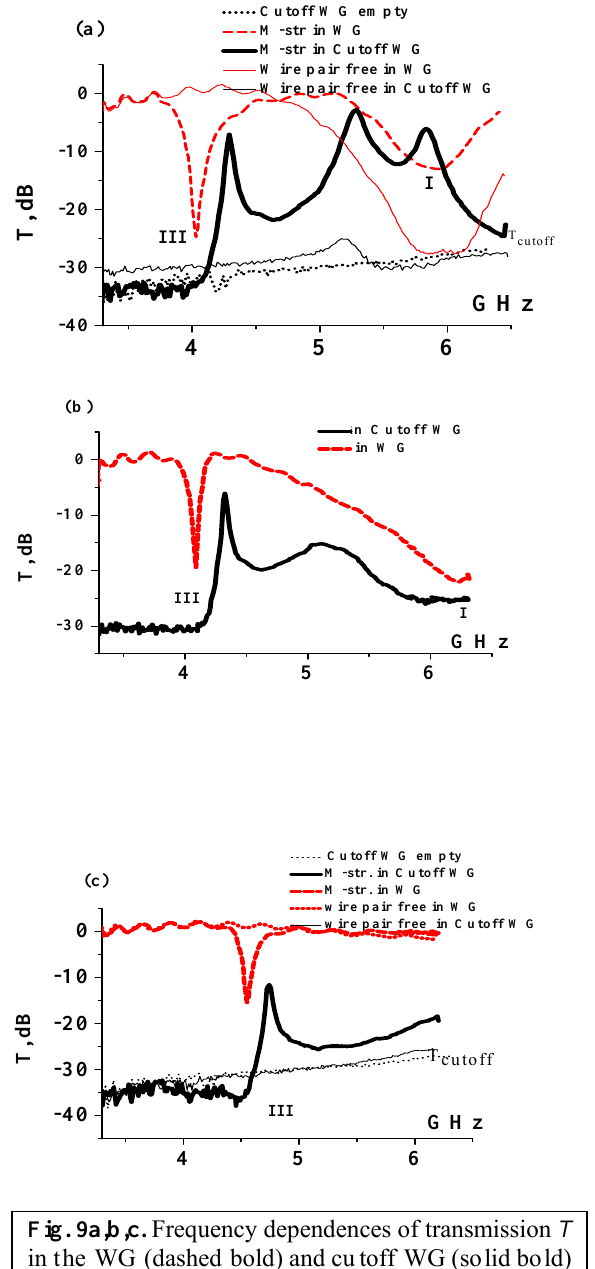
Fig. 9a,b,c. Frequency dependences of transmission T in the WG (dashed bold) and cu toff WG (solid bold) in the prese nce of m etastructure “Cut-wire pair - longitudinal cut-wire ” , d= 20mm, s= 1.1mm: